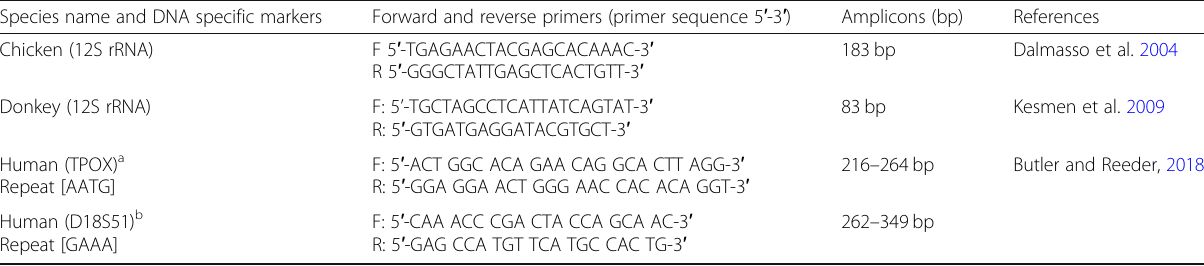
Table 1 The species-specific 12S rRNA and short tandem repeats (STRs) primer sequences, references and amplicon sizes used